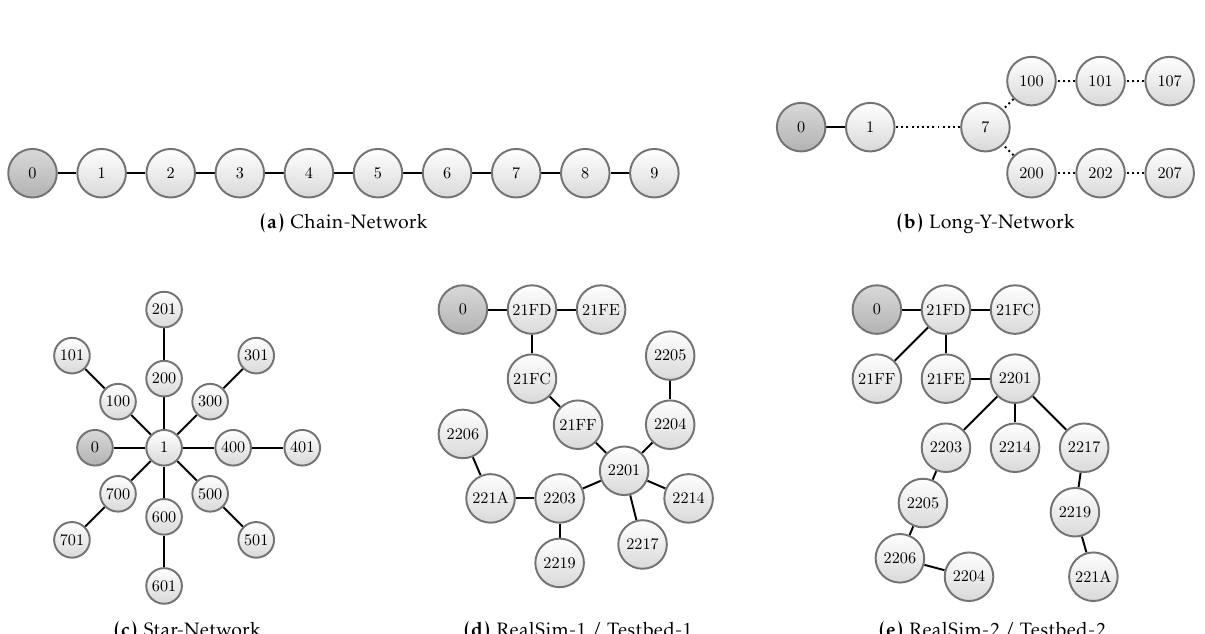
Figure 2. Network routing topologies. Edges represent static routes, the dark gray node is the